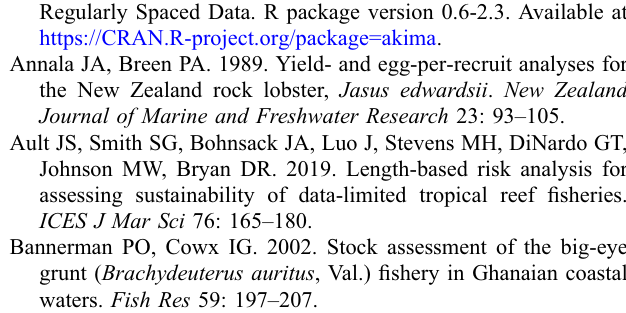
Table 1. Observed von Bertalanffy growth parameters used to analyze CYPR14.